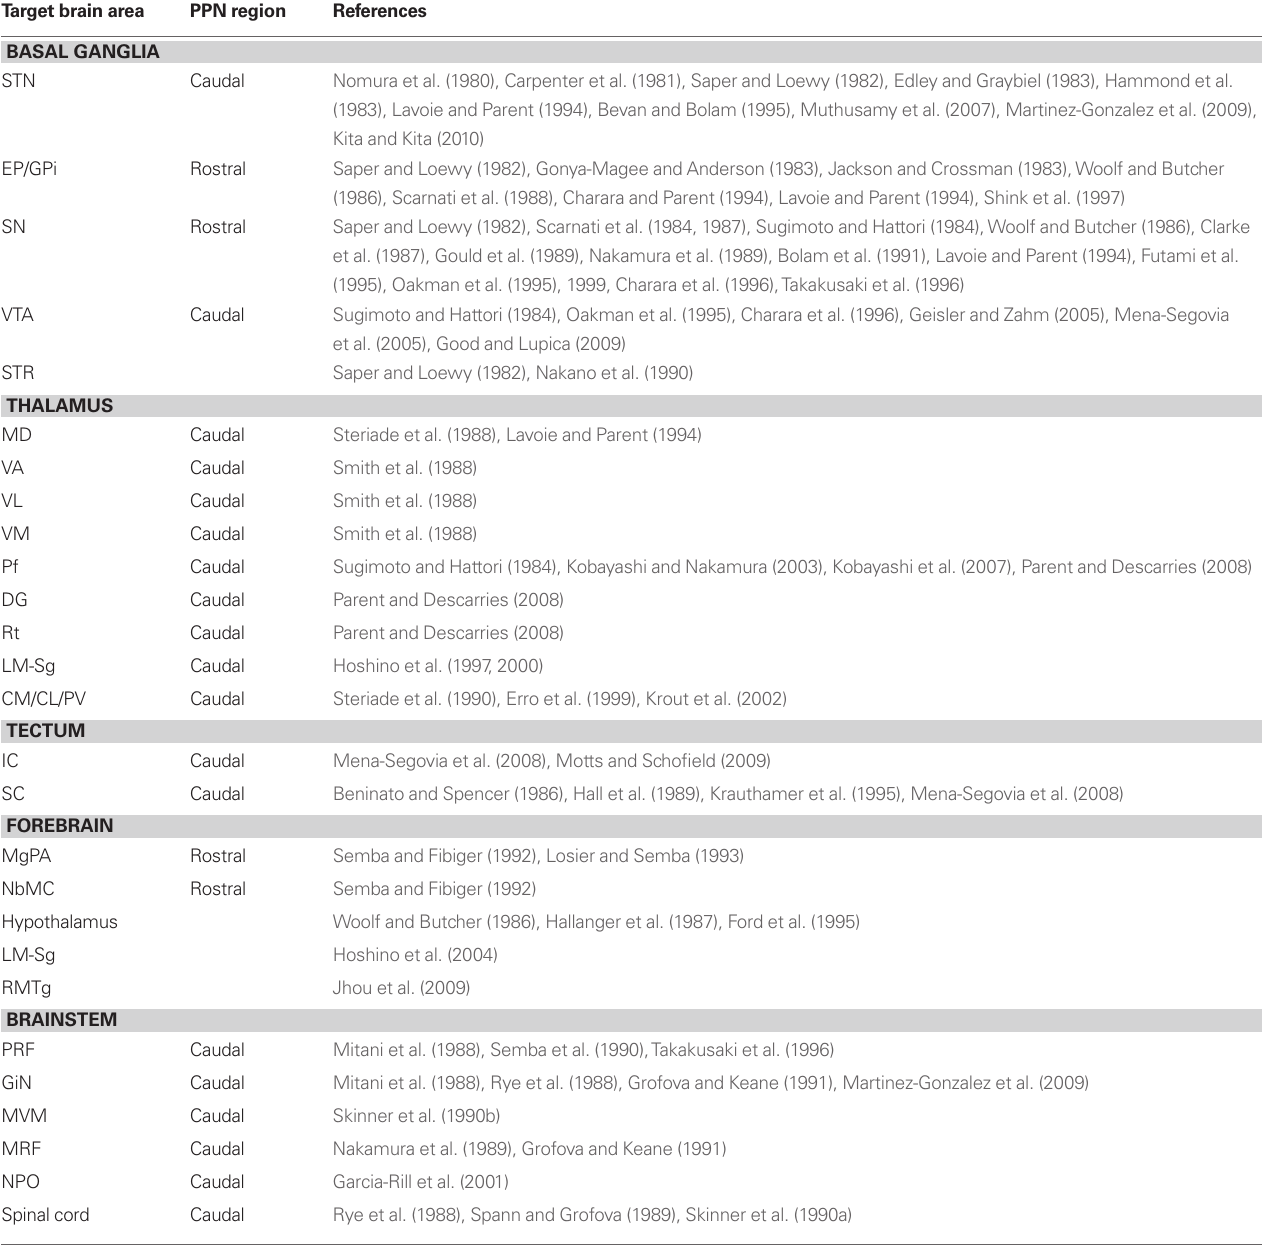
Table 1 | efferent connectivity of the pedunculopontine